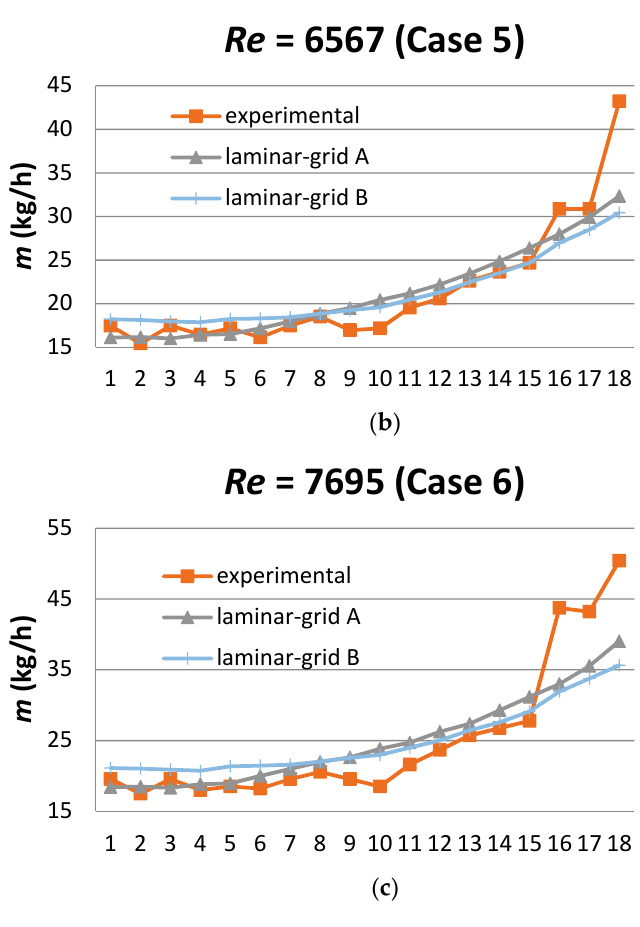
Figure 4. Comparison of numerical results (laminar flow simulations in grids A and B) with experimental ones. ( a ) Re = 4309 (Case 4); ( b ) Re = 6567 (Case 5); ( c ) Re = 7695 (Case 6).